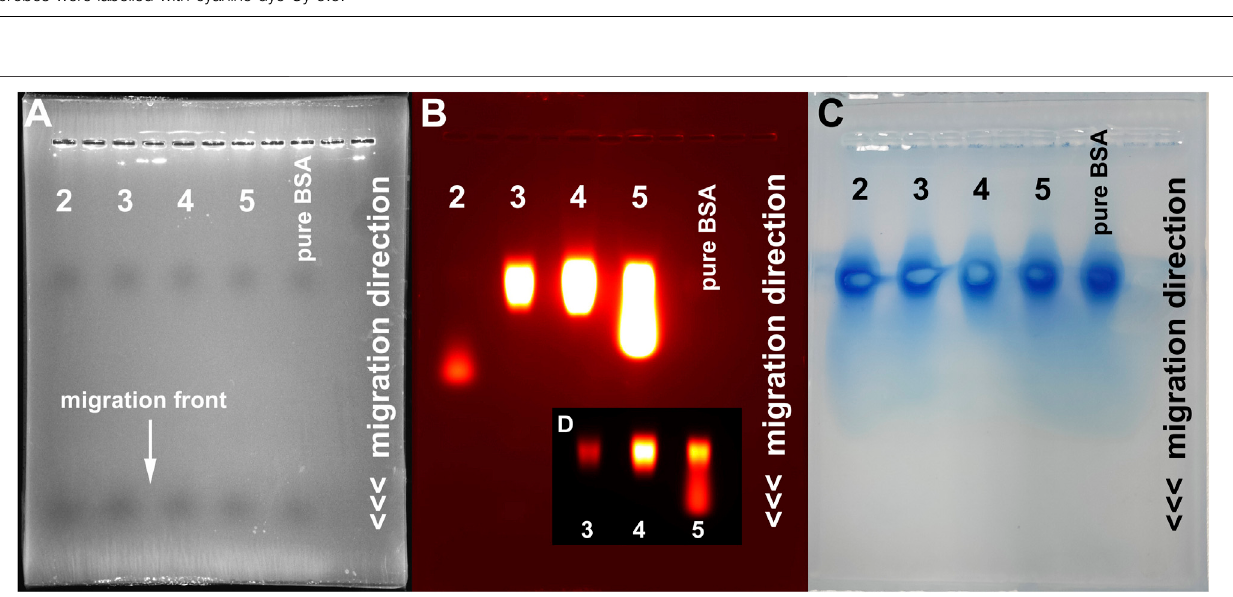
FIGURE 2 | Gel electrophoresis analysis of the four developed probes. (A) Phase contrast image showing the migration front (maximum migration distance) of the used lanes(1, 3,5,7and9).Fluorescenceanalysis (B) showsamarkedly reducedmigrationdistanceofthemodi fi edprobes 3 , 4 and 5 (lanes3,5and7)comparedto 2 . CoomassieBluestaining (C) identi fi esserumproteinlocatedatareducedmigrationdistanceinalllanes. (D) Fluorescenceimageoflanes3,5and7atreducedexposure settings, depicting the strongest signal intensity at the BSA level and a certain degree of “ spillover ” of probe 5 .